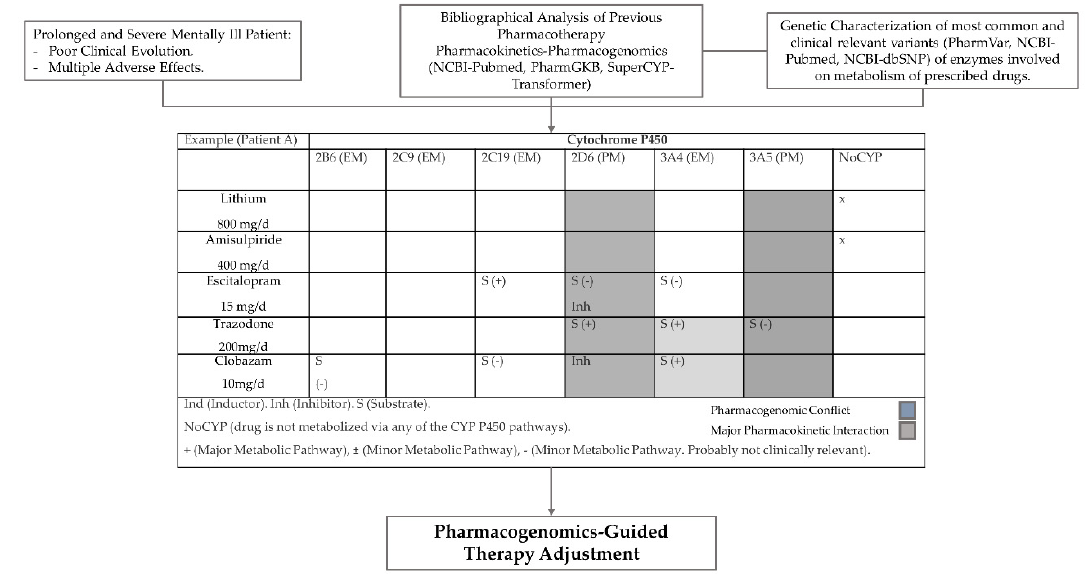
Figure 1. Practical application of the precision medicine model.